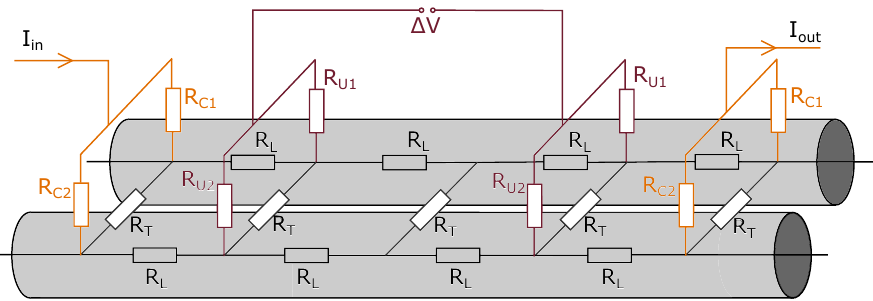
Figure 2. Schematic of the model of a hypothetical